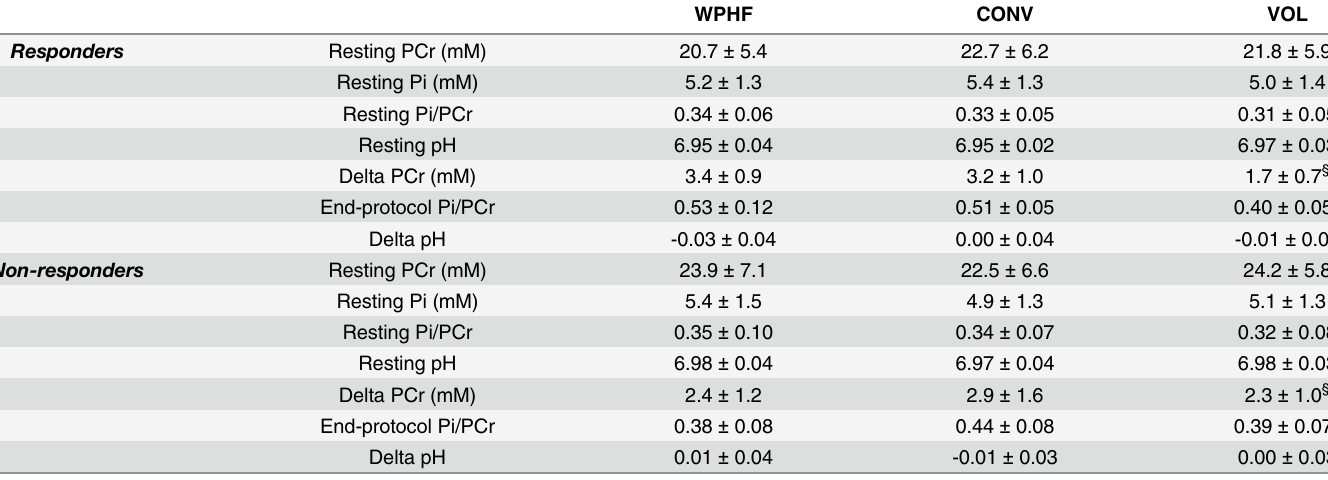
Table 1. Resting values and changes from rest (delta) for PCr, Pi/PCr and